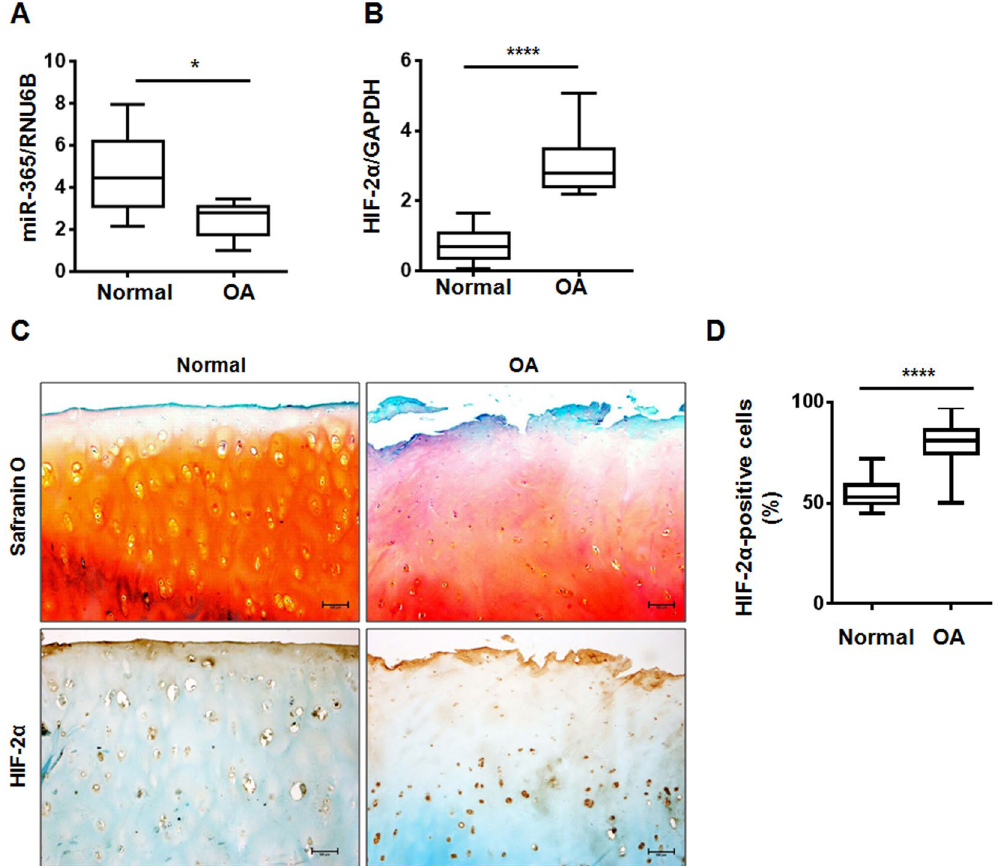
Figure 1. Relative expression of microRNA-365 (miR-365) and hypoxia-inducible factor-2 alpha (HIF-2 α ) in normal and osteoarthritic (OA) cartilage. ( A , B) Relative expression of miR-365 and HIF-2 α in normal and OA cartilage were assessed using ( A ) TaqMan miRNA assay and ( B ) SYBR Green-based real-time polymerase chain reaction (PCR), respectively. RNU6B and glyceraldehyde 3-phosphate dehydrogenase (GAPDH) were used as endogenous controls. * P < 0.05, **** P < 0.001 vs. normal cartilage. Data are presented as the mean ± SD of data from duplicate experiments using cartilage from different donors (n = 10). ( C ) Immunohistochemical staining for HIF-2 α and safranin-O staing in normal and osteoarthritis (OA) cartilage. Expression of HIF-2 α was determined by immunohistochemistry using anti-HIF-2 α antibody. Sections were counterstained with methyl green. Normal cartilages were obtained from femoral head of patients with femoral neck fractures and OA cartilage from knee joints of OA patients undergoing total knee replacement surgery. Data shown are representative of results from three normal and OA cartilages. The magnification is × 100. Scale bar = 100 μ m. ( D ) Quantification of HIF-2 α -positive chondrocytes. Data are presented as the mean ± SD. **** P < 0.001 vs. normal